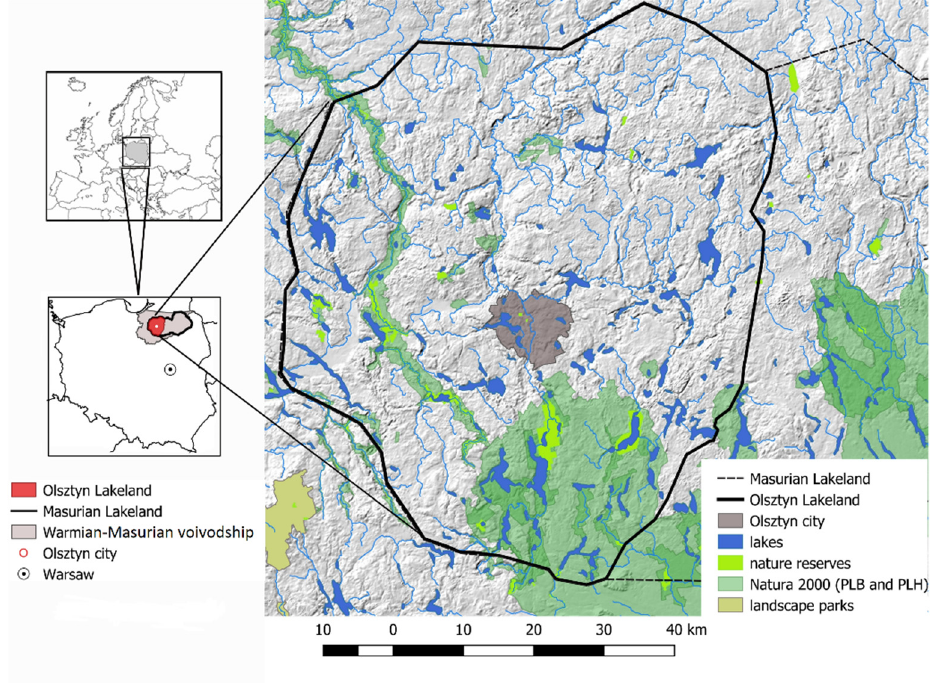
Figure 1. Distribution of lakes within Olsztyn Lakeland. The map is based on the General Geographic Database, the Database of Topographic Objects, and the Digital Elevation Model published by the National Geodetic and Cartographic Resource.